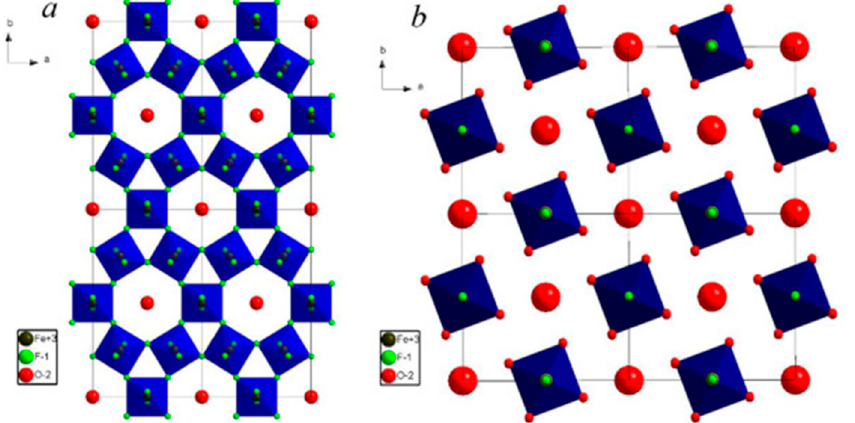
Figure 21. [001] direction projection of four unit cells of phase FeF 3 ∙ 0.33 H 2 O ( a ) and β -FeF 3 ∙ 3 H 2 O ( b ) [244].